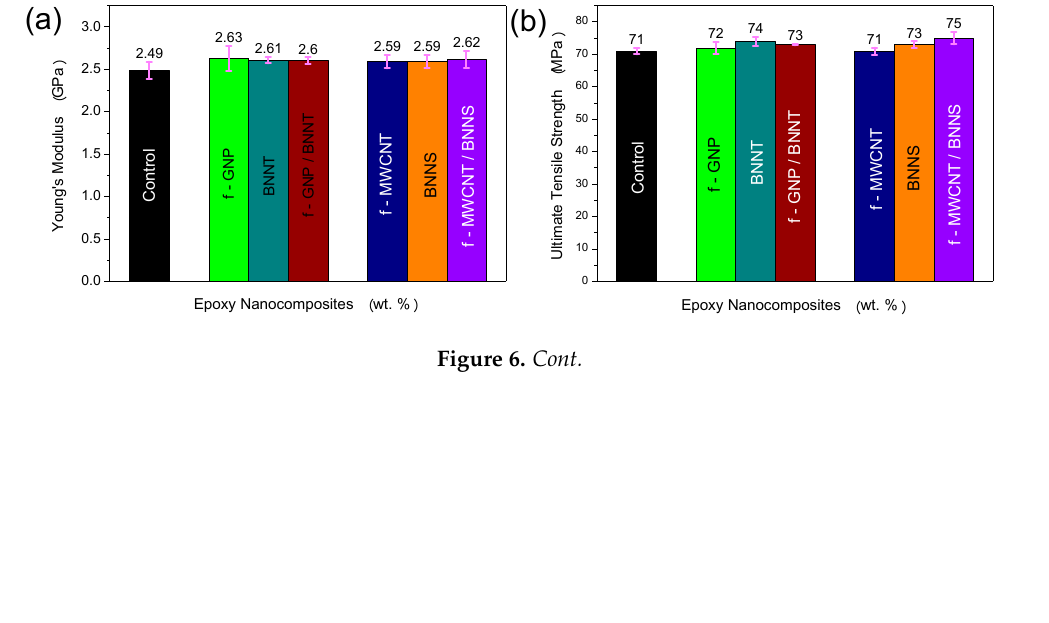
Table 3. Glass transition temperature T g and CTE of the f-MWCNT series relative to the neat epoxy. Loading of MWCNT (wt %)